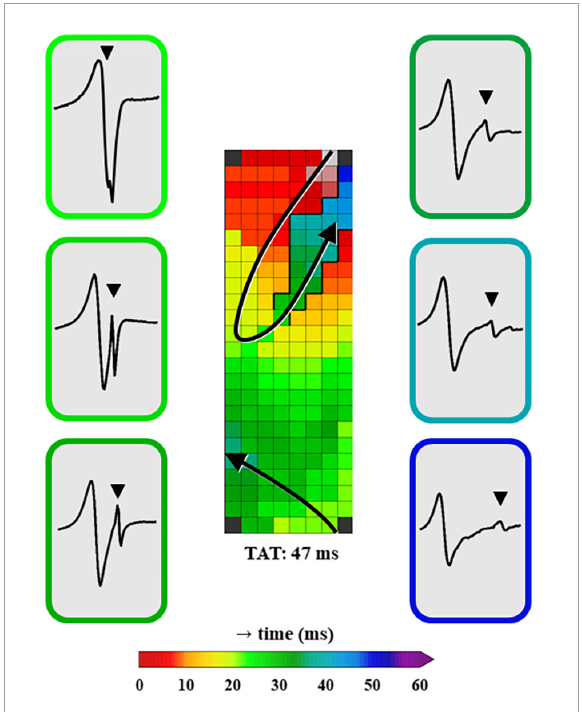
FIGURE4 A color-coded activation map, constructed using unipolar EGMs in which all negative deflections are annotated. Additionally, examples of EGMs in the LOM area recorded at distinct moments of LOM activation are shown. The EGMs are depicted in chronological order of LOM activation and the color surrounding each EGM represents the LAT of the recording site within the LOM. EGM, electrogram; LAT, local activation time; LOM, ligament of Marshall; TAT, total activation time. The bold black lines represent lines of conduction block and the black triangle in the EGM indicates a LOM